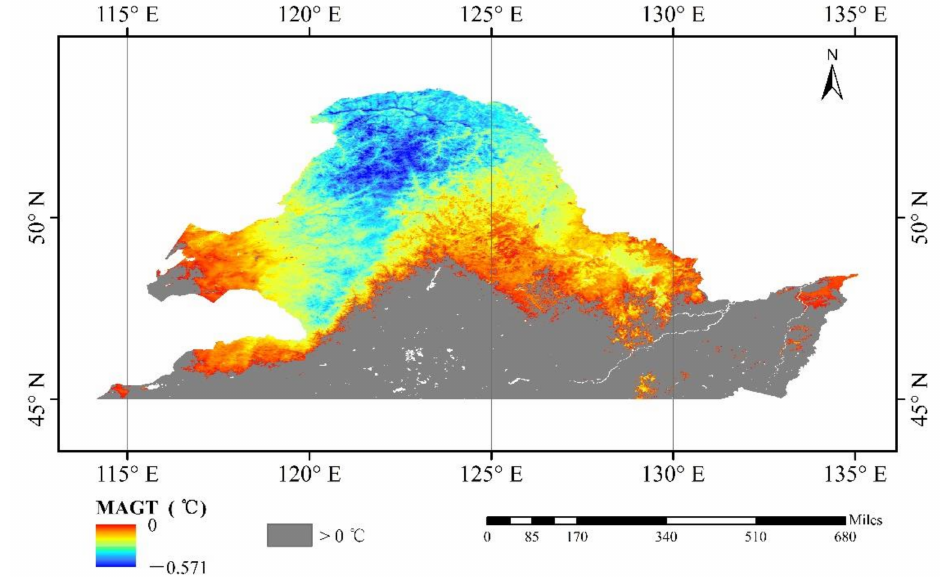
Figure 4. Spatial distribution of MAGT values in Northeast China from 2001 to 2018.